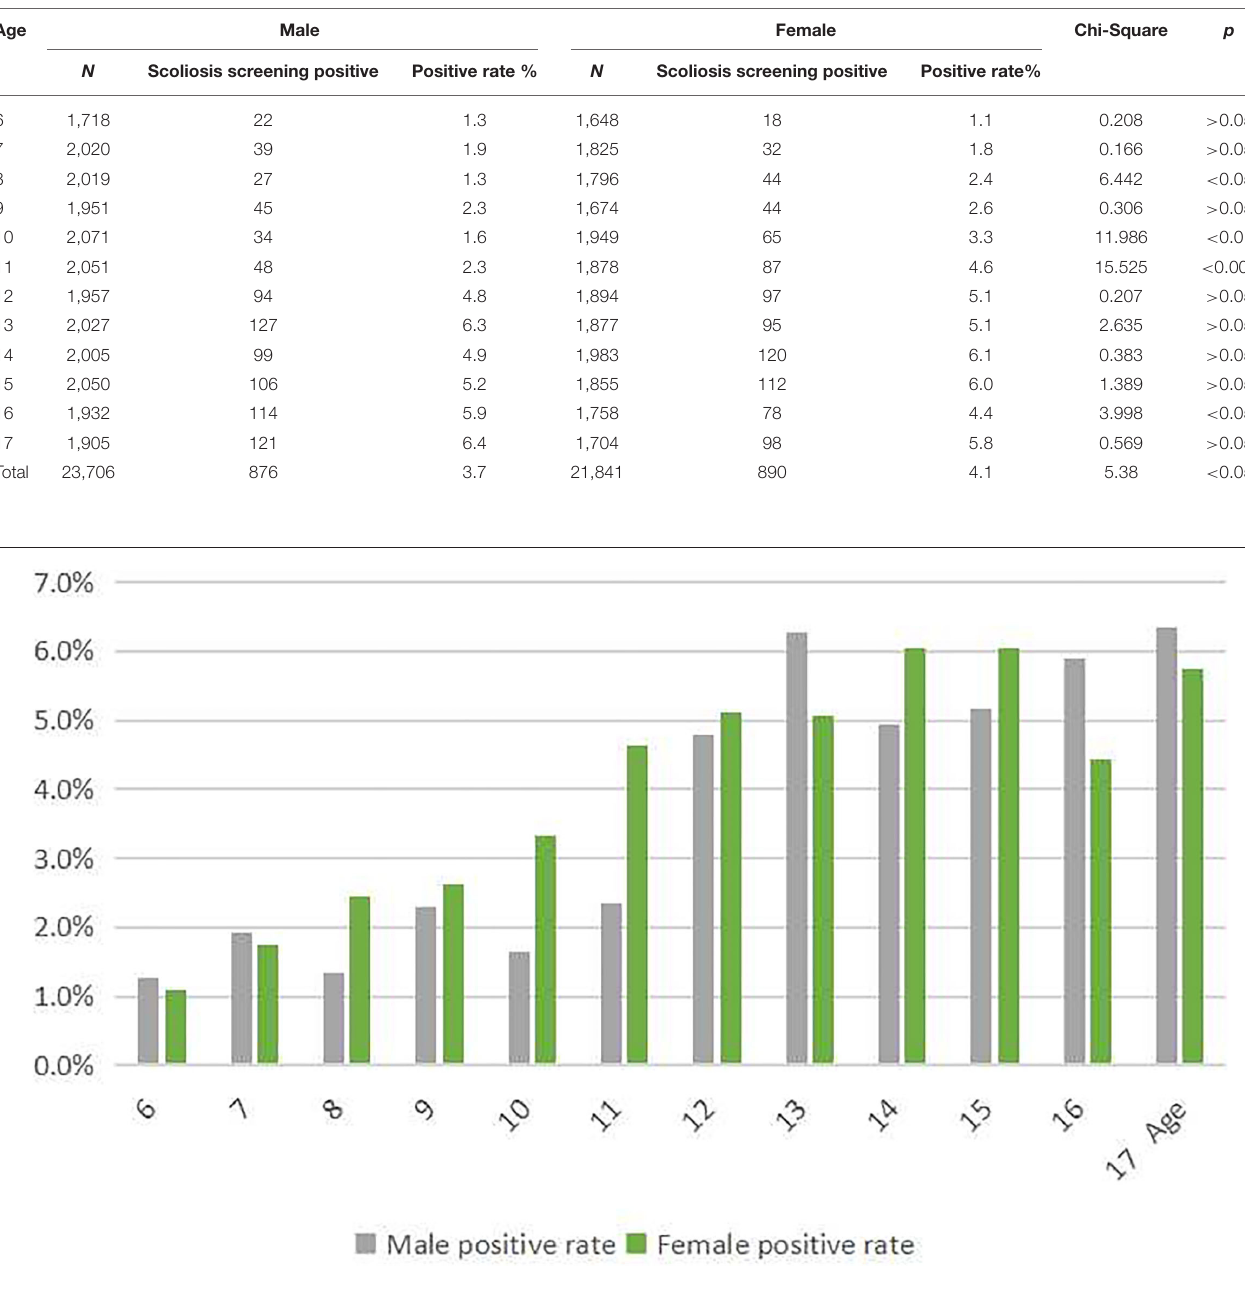
FIGURE 2 | The prevalence of scoliosis screening positive among children and adolescents stratified by